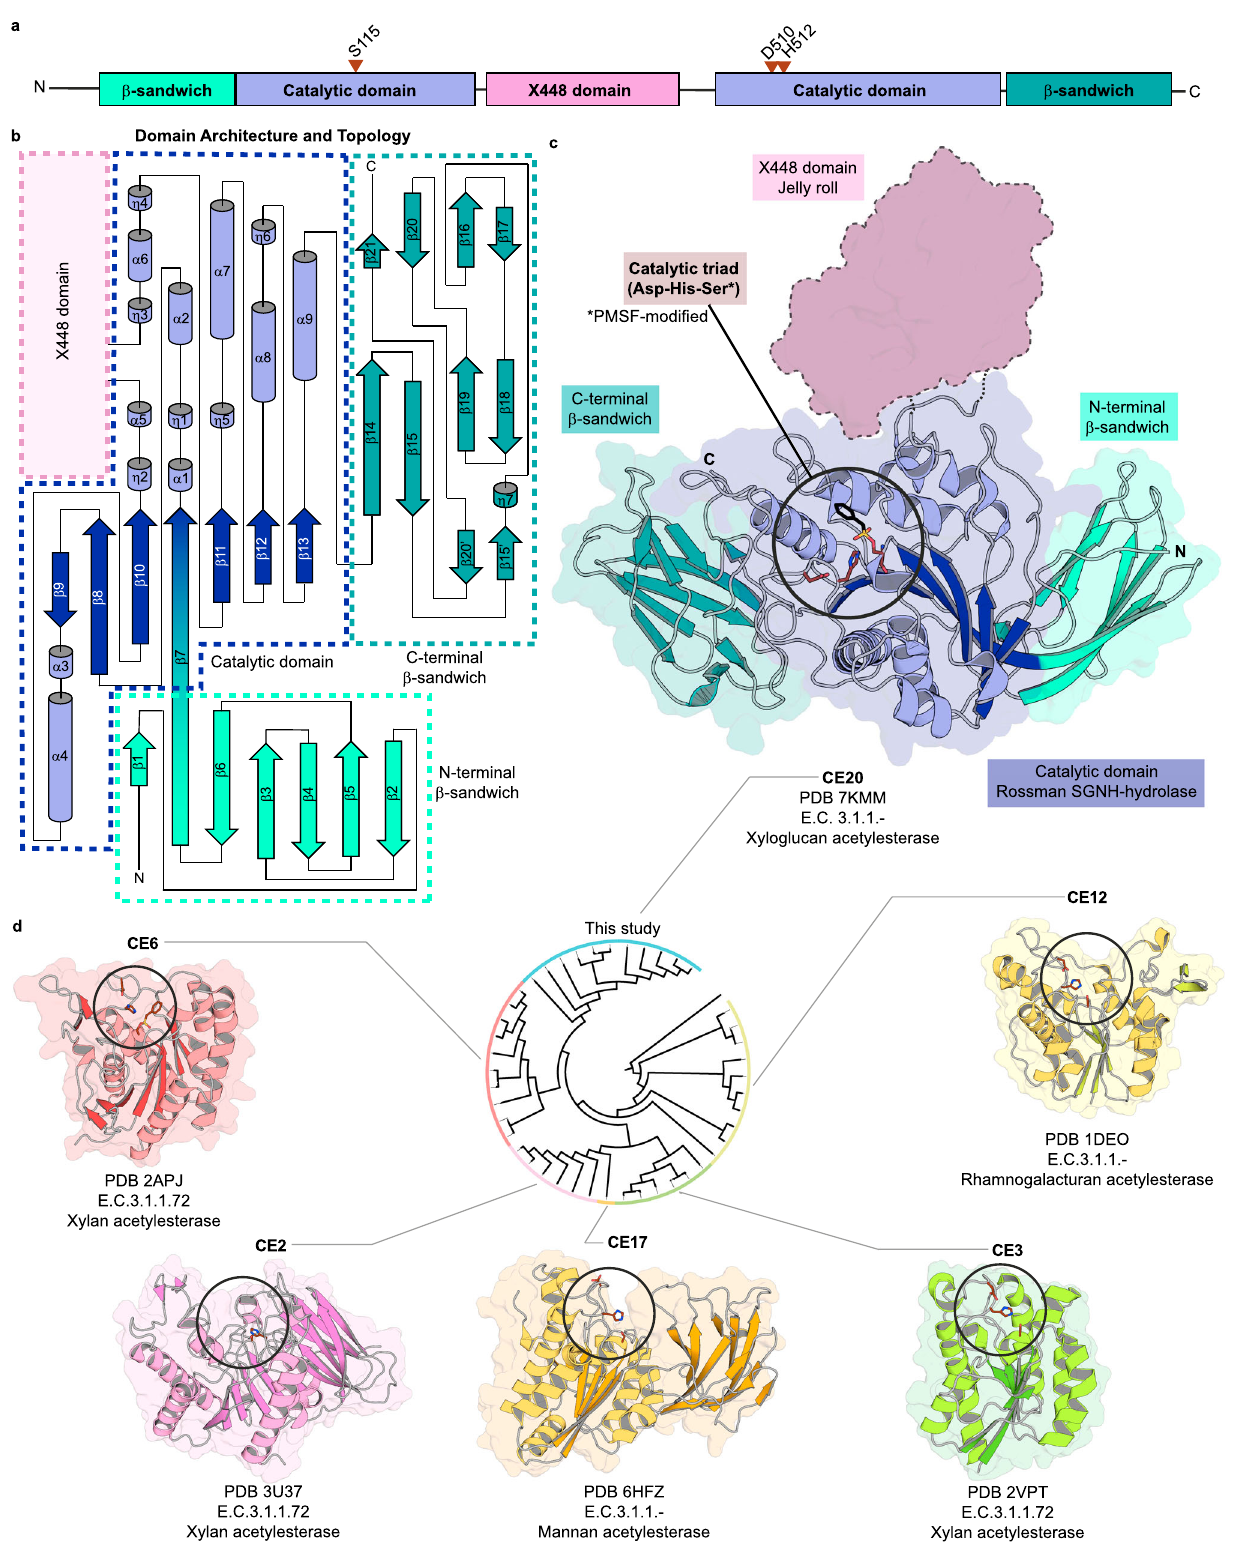
Fig. 3 A distinctive type of carbohydrate acetylesterase. a Domain organization showing the position of catalytic residues (red triangles); b structural topology and c crystal structure color-coded according to a . d Dendrogram of CE families based on phylogenetic analysis of the catalytic domain showing the structure of a representative member of each family. Circles indicate the active site. Catalytic residues (carbon atoms in brown) and PMSF (carbon atoms in black) are shown as sticks. The Xanthomonas acetylesterase, discovered in this study, is the founding member of the CE20